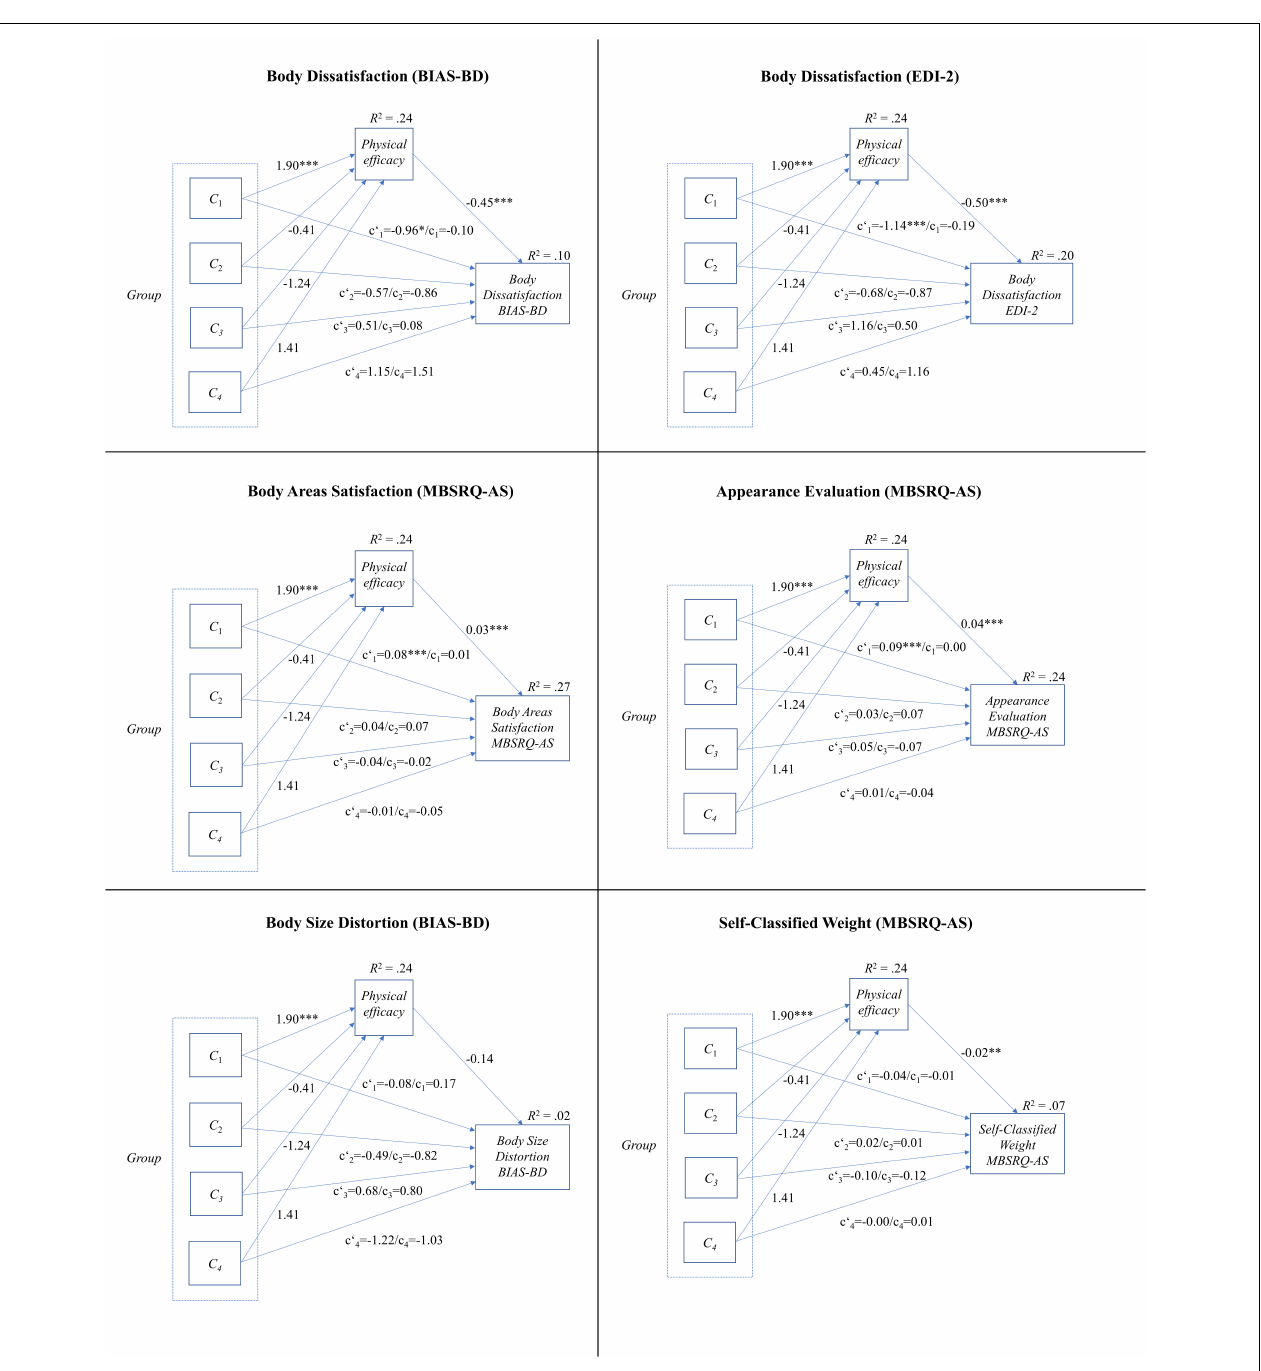
FIGURE 1 | Mediation models of group contrasts, physical efficacy, and perceptual, cognitive, and affective body image measured via the Body Image Assessment Scale-Body Dimensions (BIAS-BD; Gardner et al., 2009), the Eating Disorder Inventory-2 (EDI-2, Garner, 1991; German version by Thiel et al., 1997), and the Multidimensional Body-Self Relations Questionnaire-Appearance Scales (MBSRQ-AS; Cash et al., 1986; German version by Vossbeck-Elsebusch et al., 2014). Contrast 1: exercise versus non-exercise; contrast 2: yoga and ballroom dance versus team and individual sports; contrast 3: yoga versus ballroom dance; contrast 4: team versus individual sports. ∗ p ≤ 0.05, ∗∗ p < 0.01, ∗∗∗ p < 0.001.